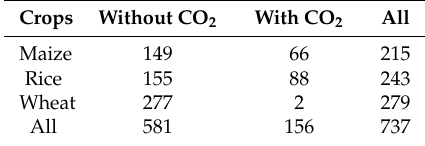
Figure 1. The 7 regions of China (except Taiwan, Hong Kong and Macau). (The di ff erent colors in the figure represent di ff erent regions. In each region, there are its provinces, and the label on the map is the name of the province.) Table 1. Statistical results of sample size under di ff erent conditions of di ff erent